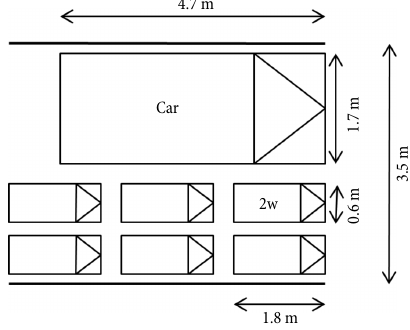
Fig. 3. MTW lane-sharing, a hypothetical